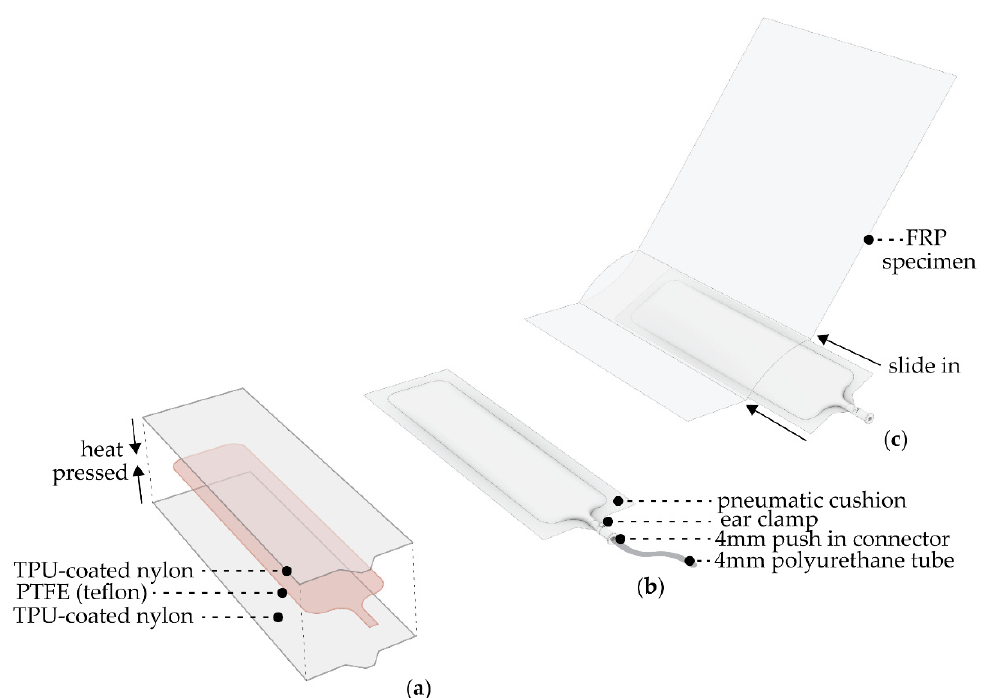
Figure 5. Configuration of pneumatic actuator exemplifying ( a ) materiality, ( b ) pneumatic fixtures and ( c ) integration of pneumatic cushion to composite specimen.